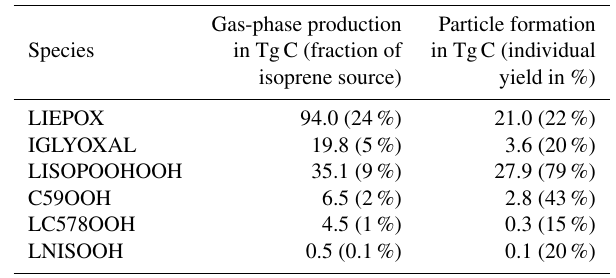
Table 3. Total annual chemical production of individual iSOA pre- cursors in 2012 and the corresponding amount of iSOA formed. In parentheses the corresponding yields are given; for the gas phase this includes how much of the total isoprene was converted to pre- cursors and the yield of those precursors into iSOA for the global annual budget.